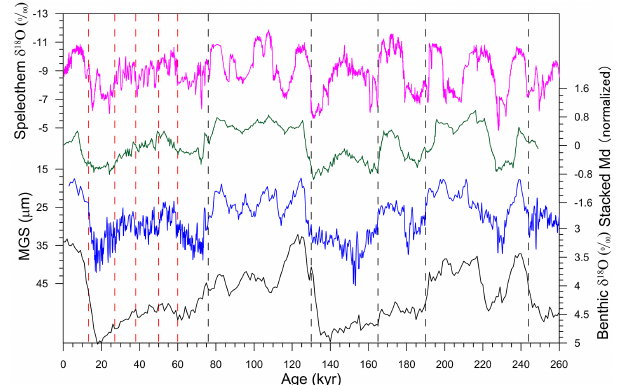
Figure 2. Comparison of Gulang MGS (blue; Sun et al., 2015) and CHILOMOS stack median grain size (Md, green; Yang and Ding, 2014) with the benthic δ 18 O (black; Lisiecki and Raymo, 2005) and Sanbao/Hulu speleothem δ 18 O (magenta; Wang et al., 2008; Cheng et al., 2009) records. The red and black dashed lines denote tie points derived from optically stimulated luminescence (OSL) dat- ing and benthic δ 18 O correlation,